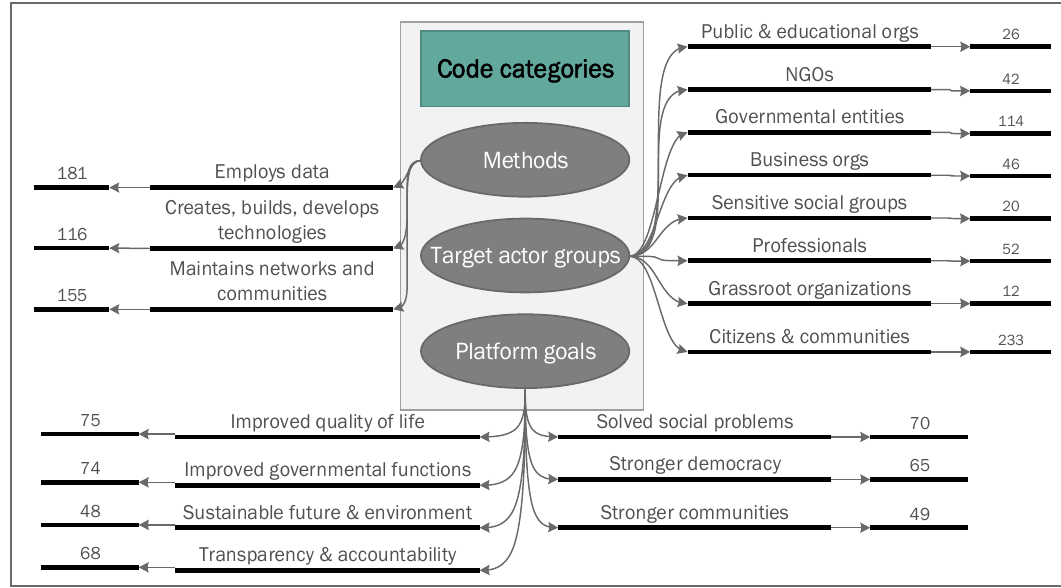
Figure 1. The Content Analysis Coding Categories. Source: developed by authors. Non Governmental Organization— NGO.